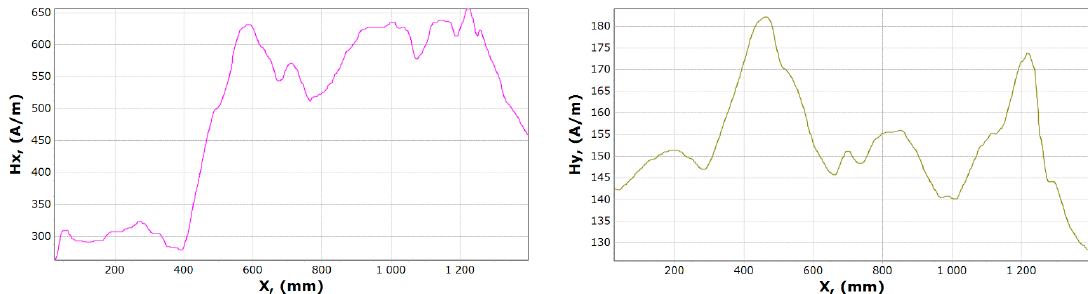
Figure 14. Graphs of tangential Hx and normal Hy component of the magnetic field, for sample 17.